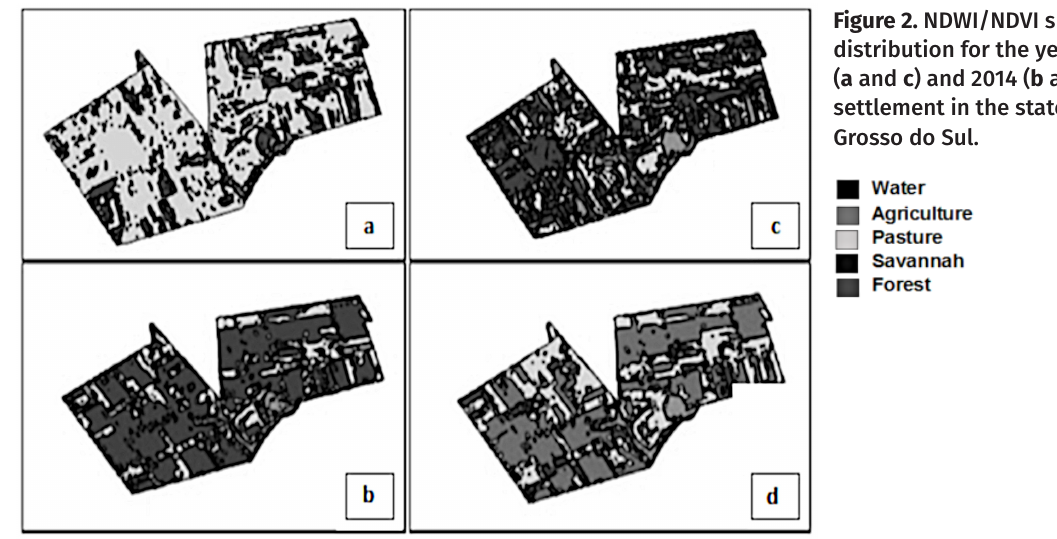
Figure 2. NDWI/NDVI